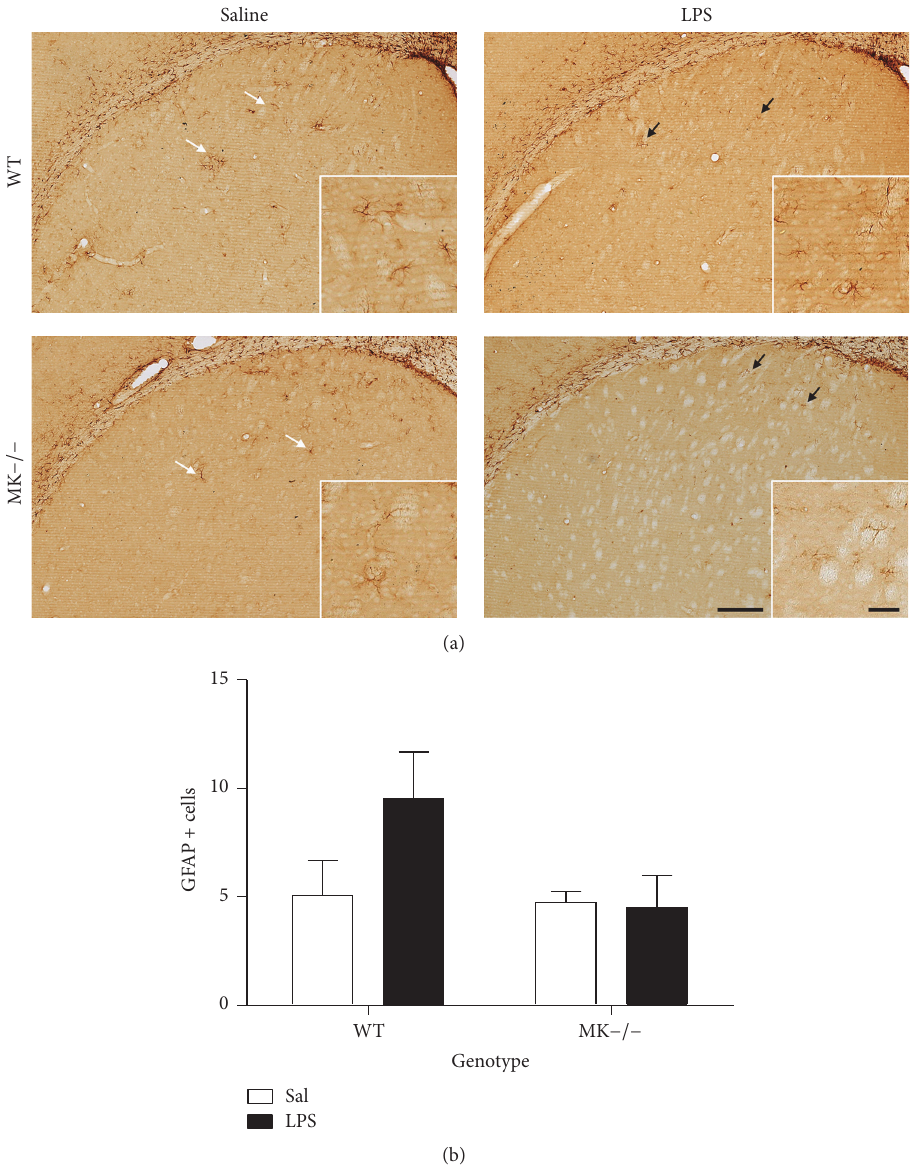
Figure 4: LPS-induced astrocytosis in the striatum of WT and MK − / − mice. (a) Photomicrographs are from GFAP-immunostained striatal sections of saline- (Sal-) treated or 0.5 mg/kg lipopolysaccharide- (LPS-) treated animals. (b) The graph represents quantification of data (mean ± SEM) obtained from the counts of GFAP-positive cells in standardized areas of the striatum. Scale bar = 200 𝜇 m. Magnified inset = 50 𝜇